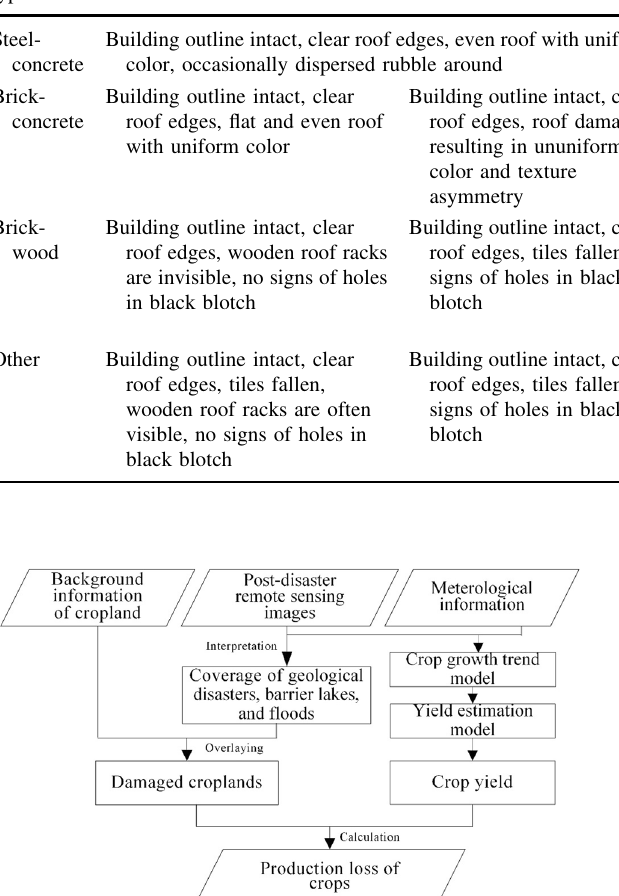
Table 3 Description of building damage states in remote sensing images (0.1 m resolution) after an earthquake disaster Structure